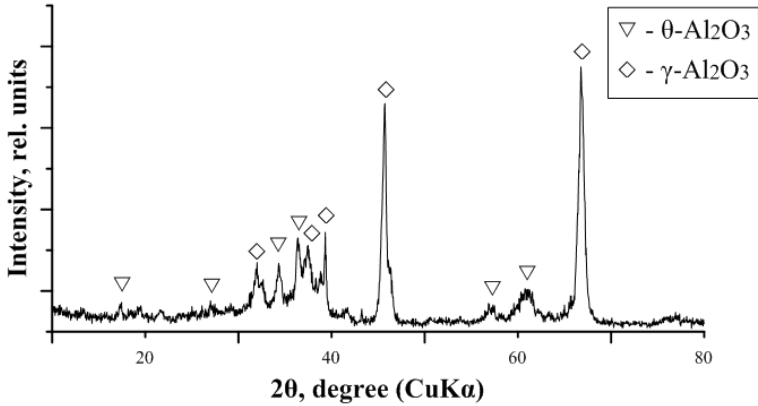
Figure 2. X-ray diffraction diagram of the Al 2 O 3 powder obtained via the plasma-chemical method.